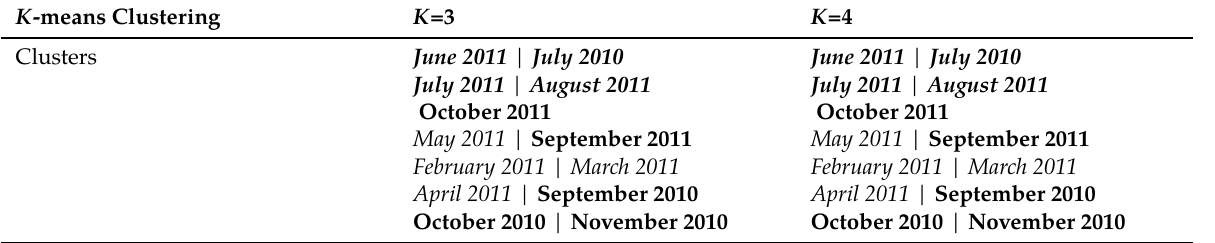
Table 1: K -means clusters for clustering into three groups ( K = 3) and into four groups ( K = 4). K -means Clustering K =3 K =4 Clusters